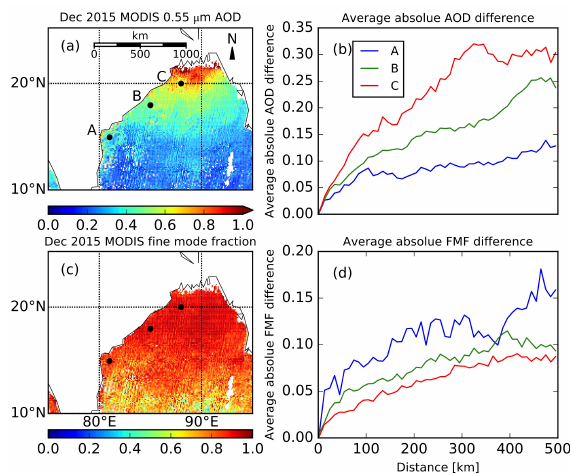
Figure 4. ( a ) and ( c ) are monthly mean 0.55 μ m AOD and fine mode fraction (FMF) from MOD04 (Terra) in December, 2015. ( b ) is average absolute AOD difference as a function a distance with respect to reference points (black solid circles in ( a )). ( d ) is similar to ( b ), but for FMF.